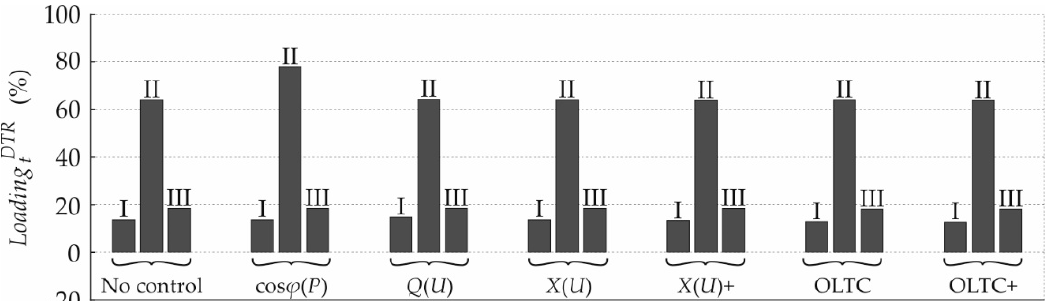
Figure 26. DTR loading within the rural LV_Link-Grid for different cases, no control, and various control strategies.